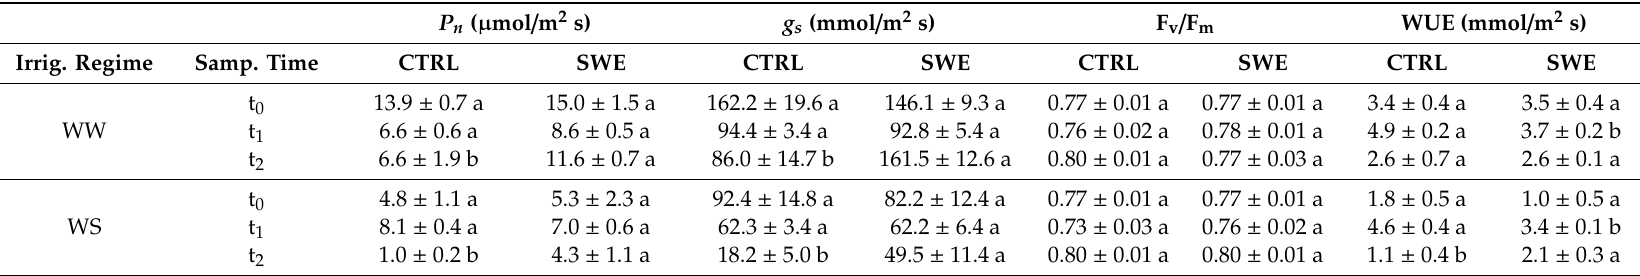
Table 1. Leaf gas exchanges and chlorophyll fluorescence in V. vinifera treated with A. nodosum extract (SWE) and untreated plants (CTRL), under two irrigation regimes (WW, well-watered; WS, water stressed).